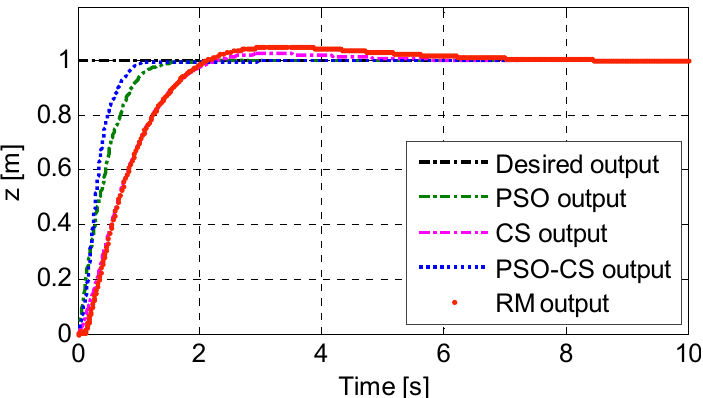
Figure 4. Quadrotor’s position y using Particle Swarm Optimization (PSO), Cuckoo Search (CS), Particle Swarm Optimization-Cuckoo Search (PSO-CS), and Reference Model (RM).